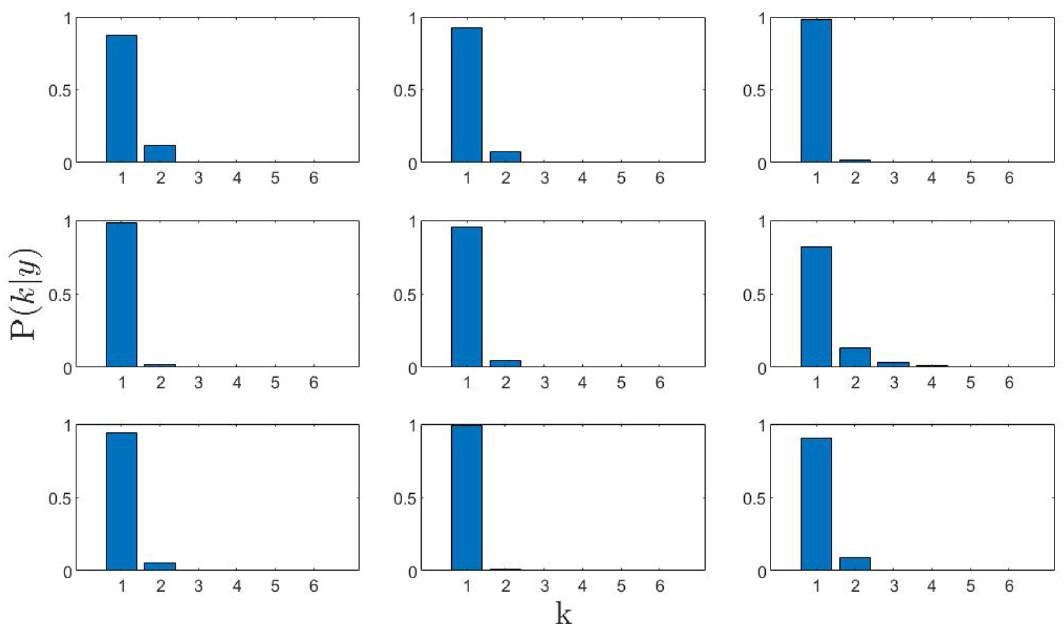
Figure 2. Posterior distribution functions of the number k of inelastic components present in the dynamic structure factor spectra shown in Fig. 1. No evidence for a second mode in the spectra is detected as the momentum transfer